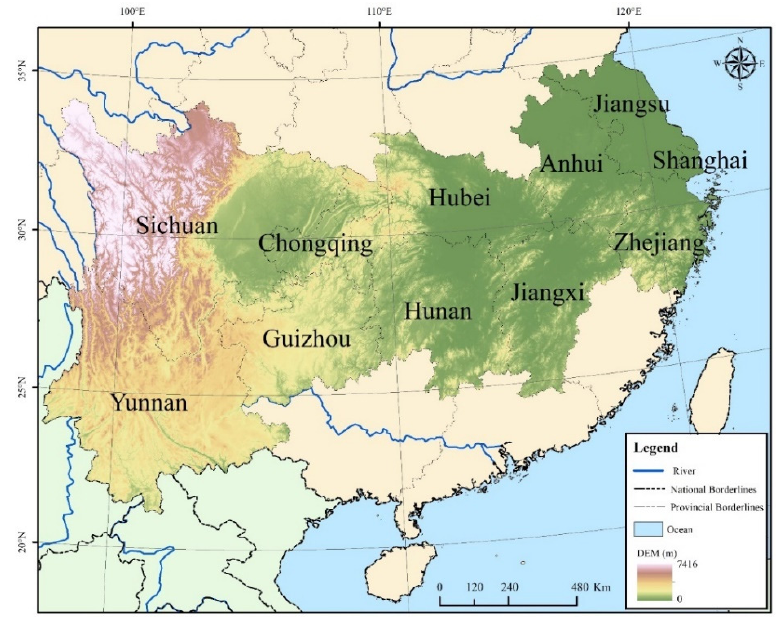
Figure 1. Geographical location of the YREB. The YREB can be divided into the upper reaches, middle reaches, and lower reaches according to the differences in geographical conditions and hydrological